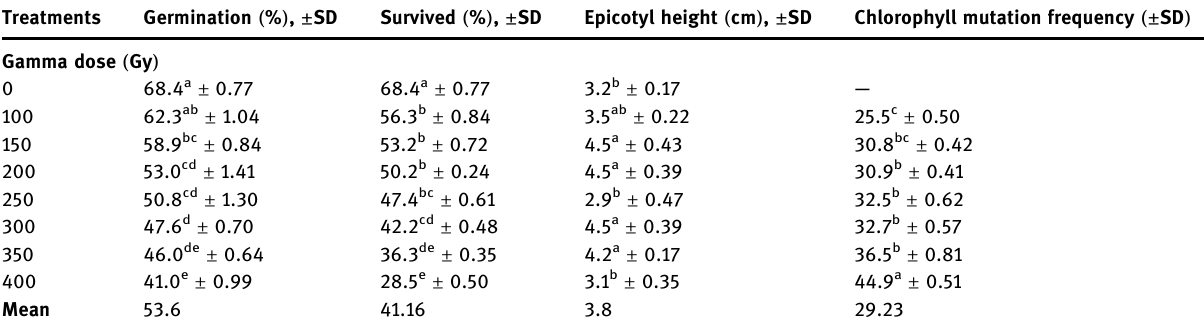
Table 2: E ff ect of di ff erent gamma irradiation doses on the four traits of three pepper cultivars Treatments